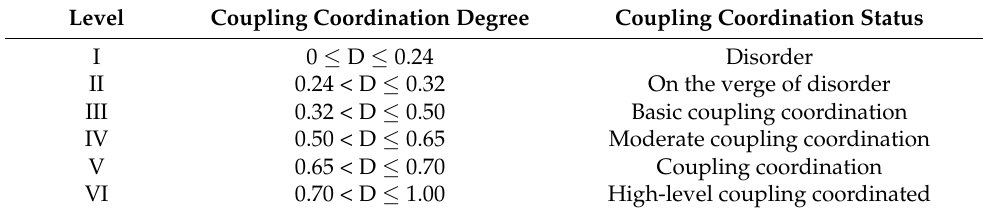
Table 3. Classification of the coupling coordination degree.